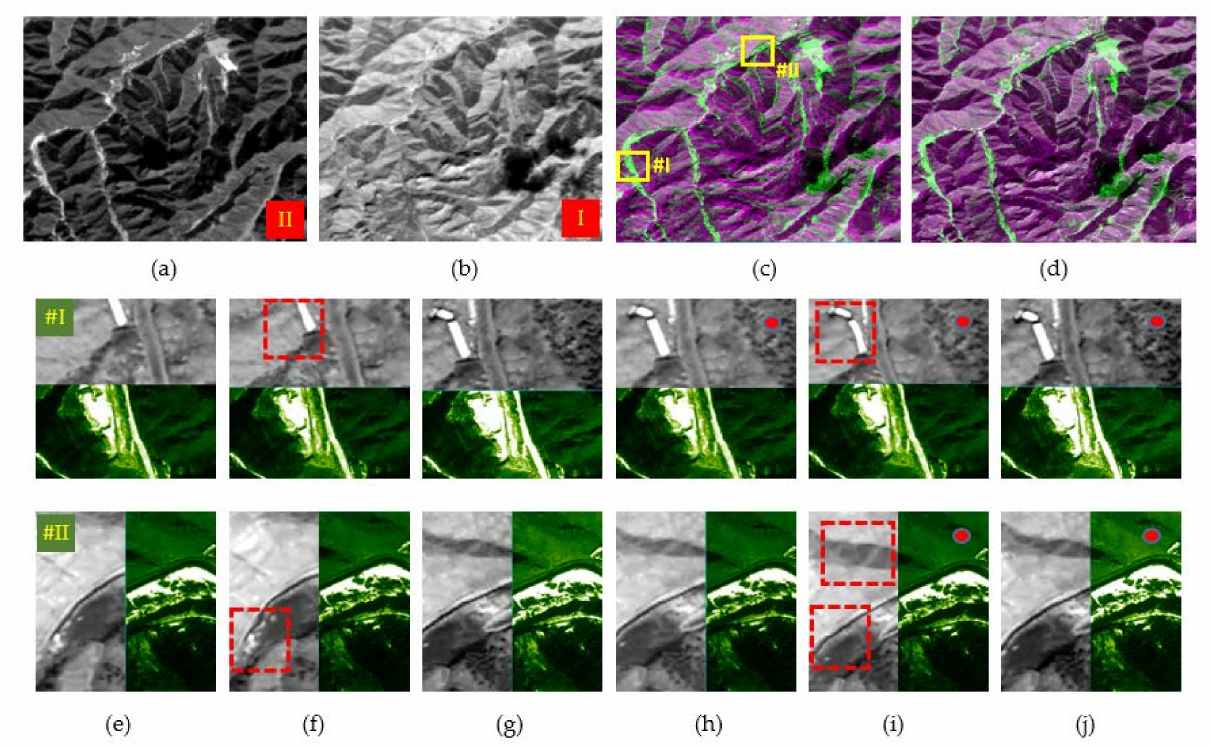
Figure 18. Registration results of image pairs in the mine production area from the GF-1 and GF-2 satellites. ( a ) Reference image from GF-2 (2400 × 3000 pixels). ( b ) Sensed image from GF-1 (original